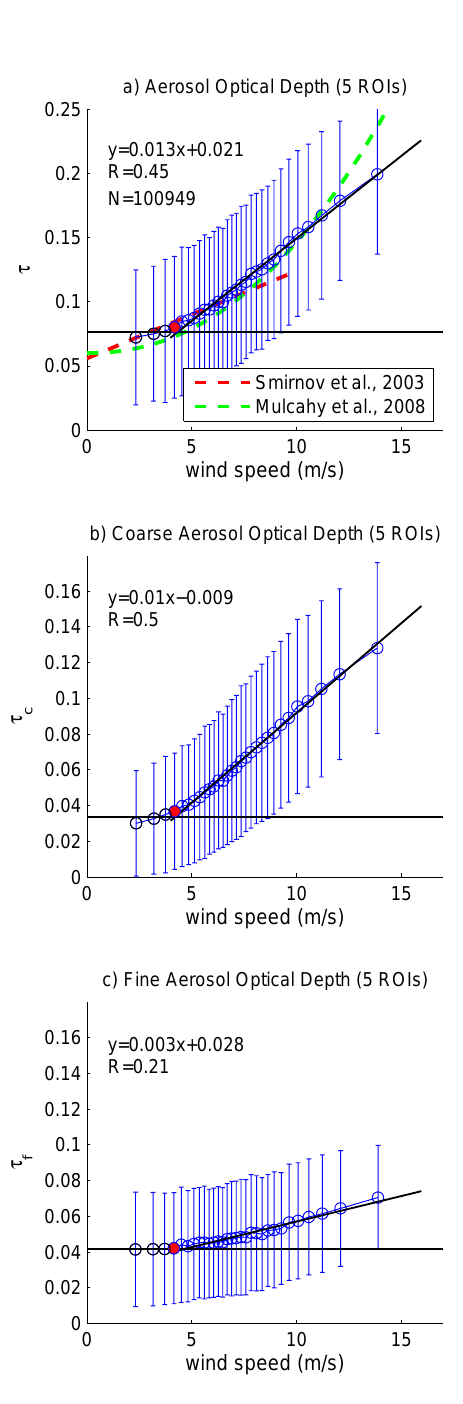
Fig. 4. MODIS-Aqua (a) τ ; (b) τ c ; (c) τ f plotted against AMSR-E W over the 5 ROIs (regions a–e in Fig. 1). Binning and statistical operations are similar to those in Fig. 4. The red data points in the upper and middle panels mark W 4 . The horizontal black lines mark τ 0 , τ c 0 and τ f 0 (panels a, b, c, respectively). The red and green dashed lines in the upper panel correspond respectively to the relationship between τ and W found by Smirnov et al. (2003), Mulcahy et al.